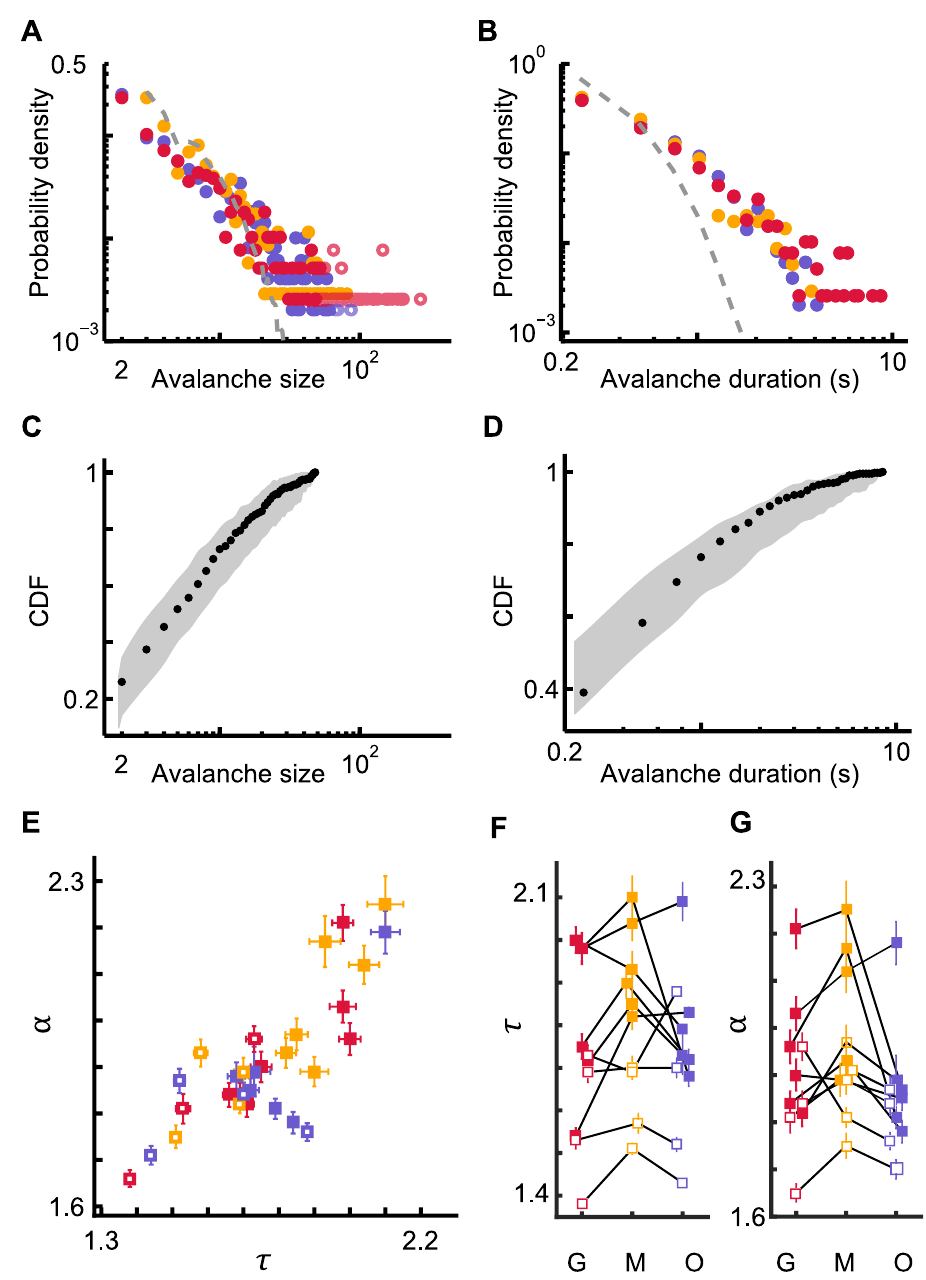
Fig 3. Avalanche size and duration distributions of cortical spiking activity for three different conditions of visual stimulation. (A, B) Probabilitydensity functions for avalanchesizes and durationsfor the three stimulus conditions: grating (red), movie (yellow),and ongoing(blue). The solid dots denotethe avalanches includedfor fitting to a truncatedpower law; open circles denoteavalanchesthat were excludedin the fitting procedure(see Materials and methods). Shuffling spike times abolishes large avalanches and results in an avalanchesize distribution (dashedgray lines) that is inconsistent with a power law. (C, D) Cumulative probabilitydensity function (CDF, black dots) of the experimental data from A and B. For visual comparison, the gray shadingindicatesthe range (5–95%) of expectedprobabilities for the truncatedpower law with the same exponentas estimated from the experimental data and with the same number of samples. (E) Estimated avalanchesize ( τ ) and duration( α ) exponents for all mice and stimulus conditions for which the avalanchedistributions fit power laws accordingto strict statistical criteria. (F, G) Estimated avalanchesize ( τ ) and duration( α ) exponents for the three stimulus conditions: grating (G), movie (M), and ongoing(O). Exponents from the same mouse are connectedby black